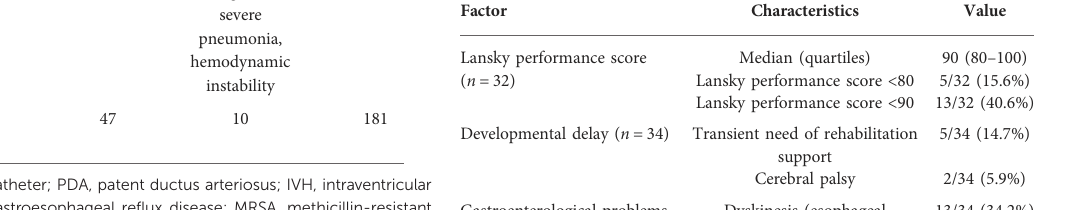
TABLE 9 Mid-term follow-up